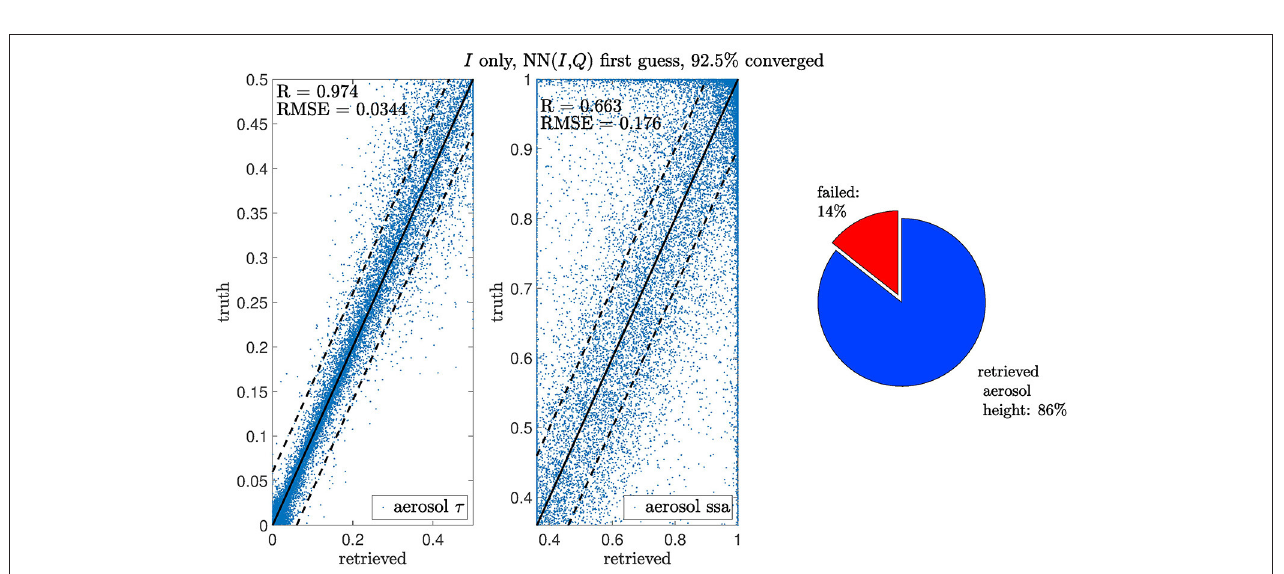
FIGURE 7 | Total radiance-only retrieval. Identical to Figure 4 except only I was used in the retrieval, not Q . By using the neural network based first guess, we are able to retrieve aerosol optical depth and also vertical location when using total radiance-only in the OE/LM retrieval step, but the aerosol single-scattering albedo is more difficult to